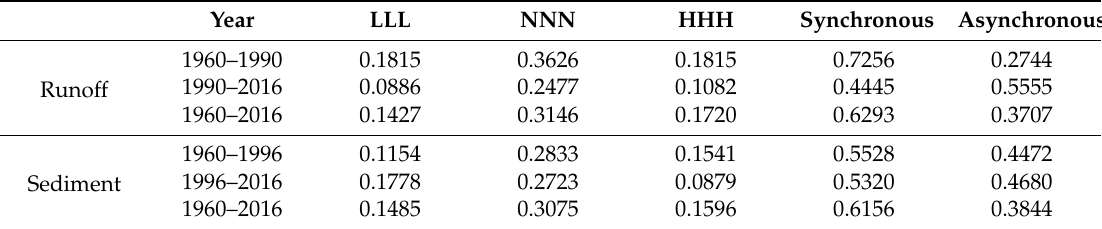
Table 3. Probabilities of synchronous and asynchronous high–low runoff–sediment of the three